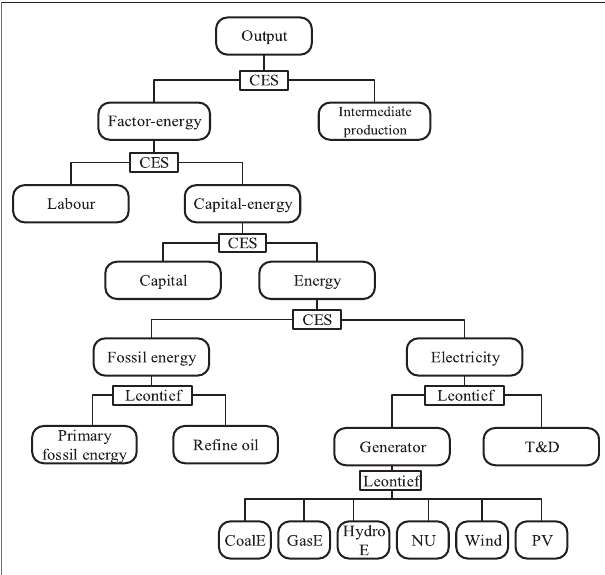
FIGURE 2 | Production function